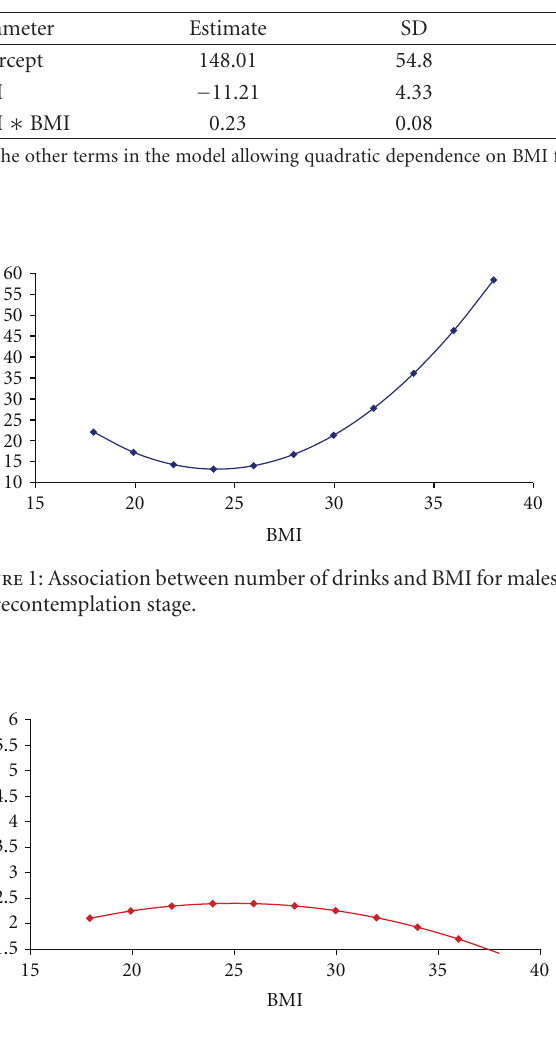
Table 2: Association of number of drinks With BMI for males in precontemplation stage 1 .